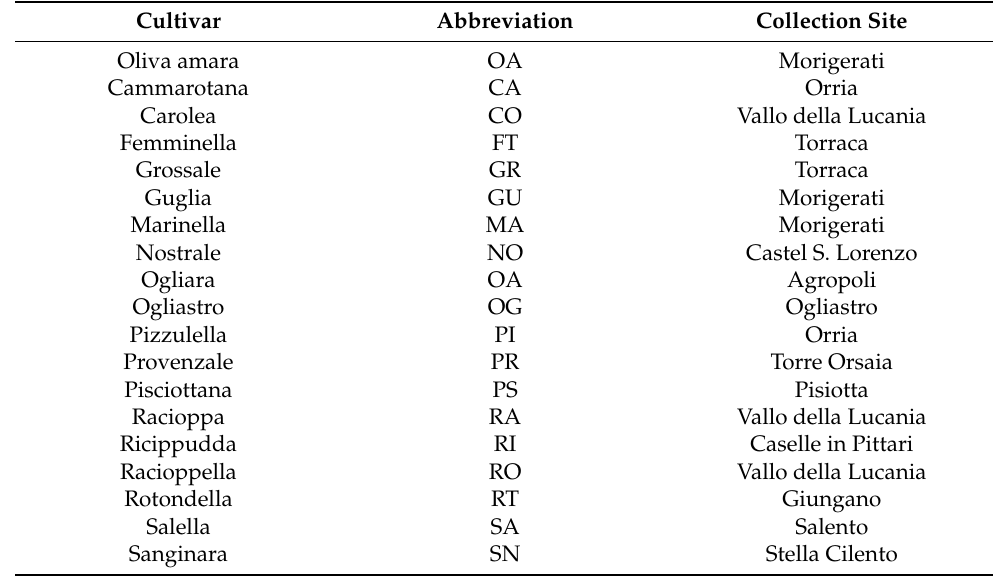
Table 1. List of the studied cultivars, abbreviations, and collection sites.